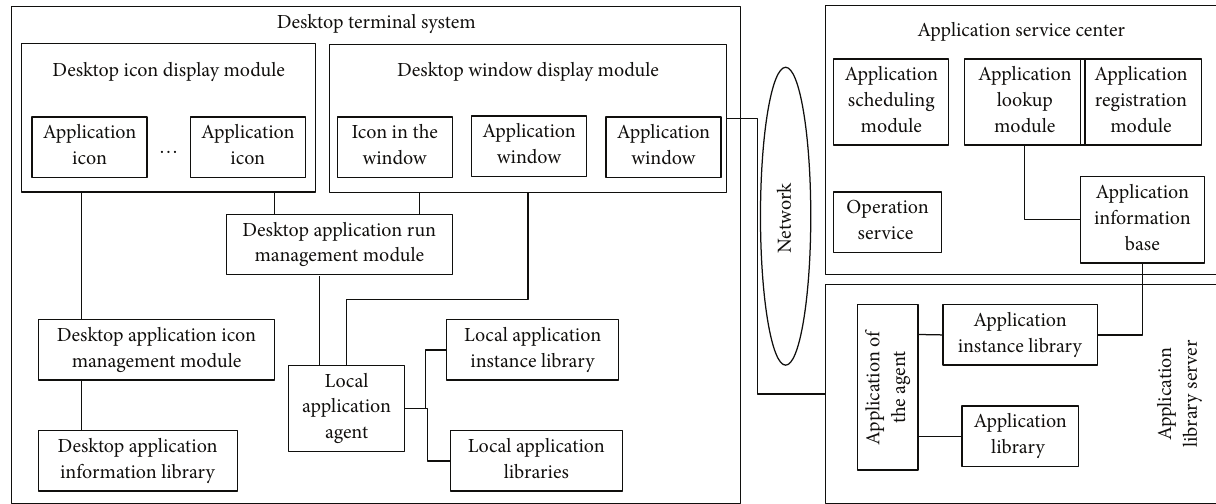
Figure 3: Multigranularity information